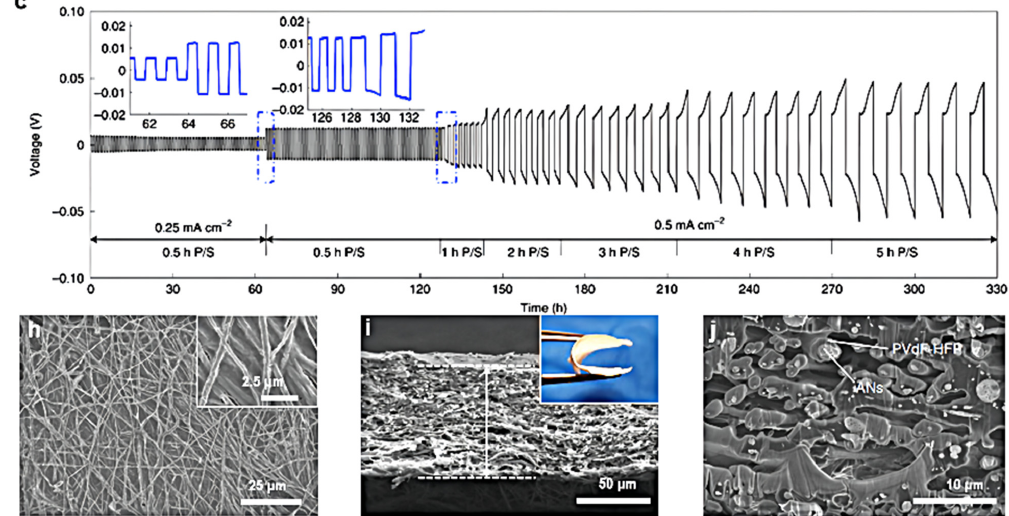
Figure 5. ( a ) Schematic configuration of Na||Na symmetric battery; ( b ) comparison of EIS of the Na symmetric cells at RT and 80 °C with the cycling of 0, 128, and 330 h; ( c ) galvanostatic cycling of the Na symmetric cell at 80 °C at 0.25 and 0.50 mA cm –2 ; the corresponding SEM images of YSZ-Na- β ”- Al 2 O 3 /Na interfaces at 80 °C with cycling times of ( d ) 0 h, ( e ) 128 h, and ( f , g ) 330 h, reproduced with permission from Reference [112] Copyright 2022, Springer Nature. ( h ) Surface, ( i ) cross-sectional SEM images, and ( j ) enlarged cross-sectional SEM image of ANs-PVdF-HFP membranes, repro- duced with permission from Reference [114] Copyright 2019, Springer Nature.